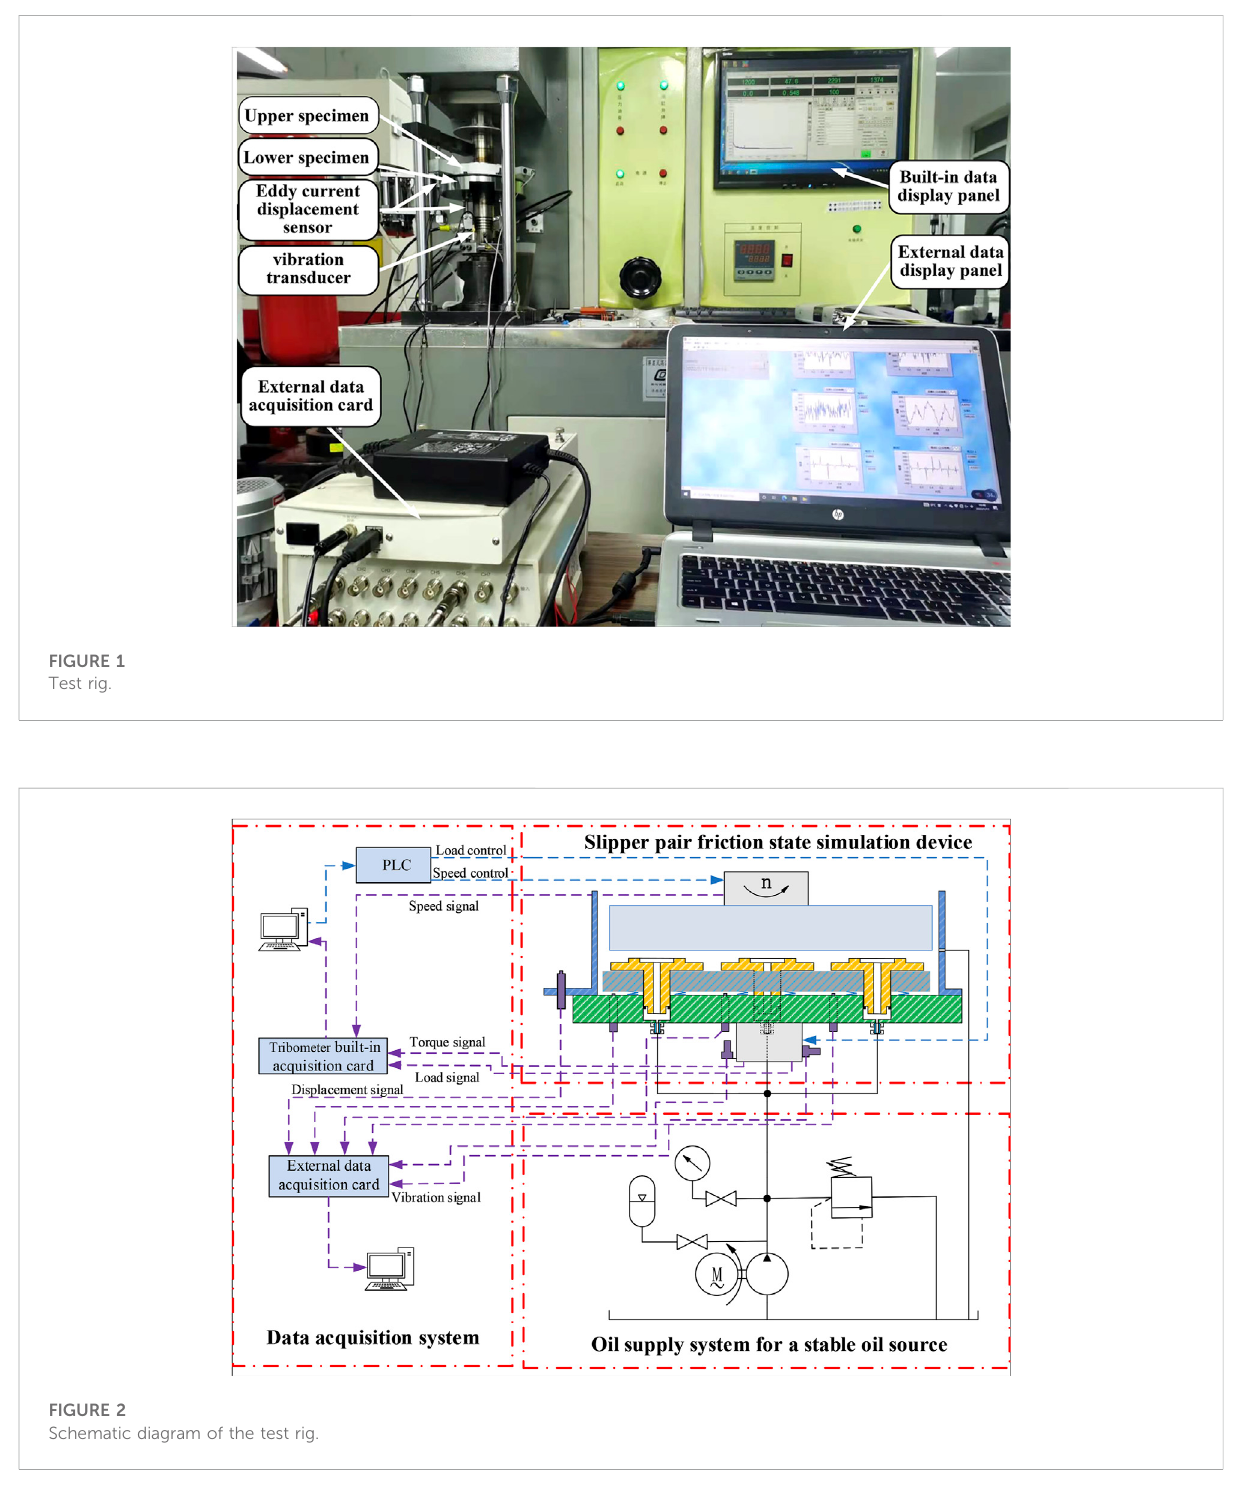
FIGURE 2 Schematic diagram of the test